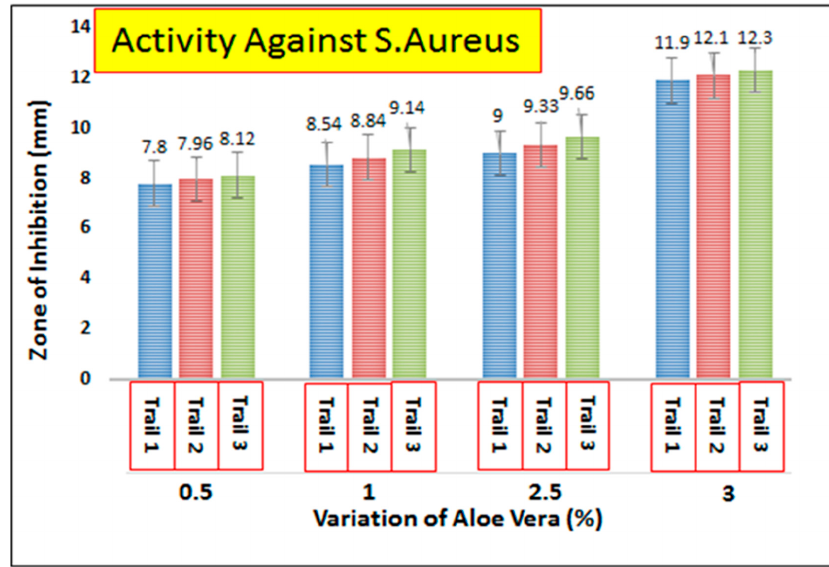
Figure 11. Antibacterial e ffi ciency of AV / PVA nanofibers against Escherichia coli .